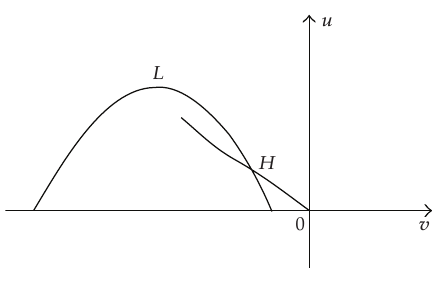
Figure 2: Relative position of L and H in (cid:3) 2 (cid:4)